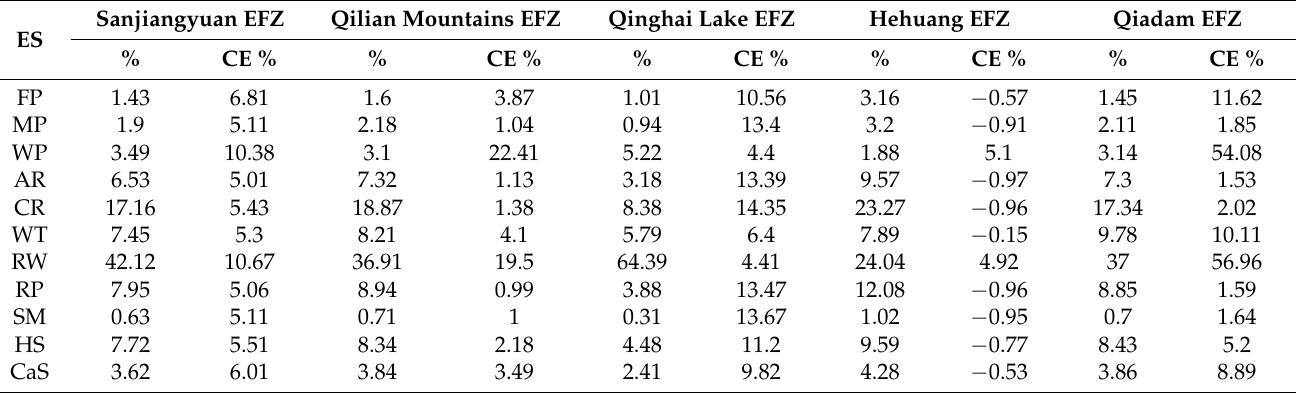
Table 3. Change rate of ecosystem service value of the five ecological function zones during